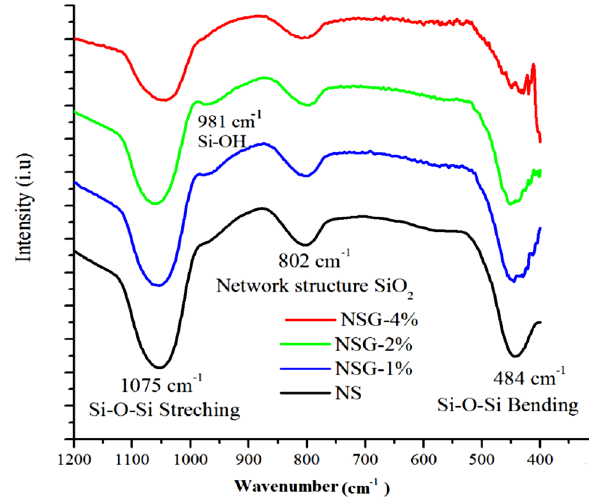
Figure 5. FTIR analysis of samples.